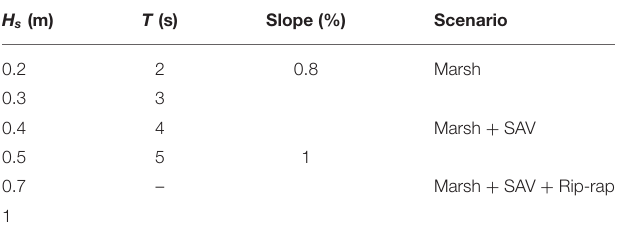
TABLE 2 | Parameters for run